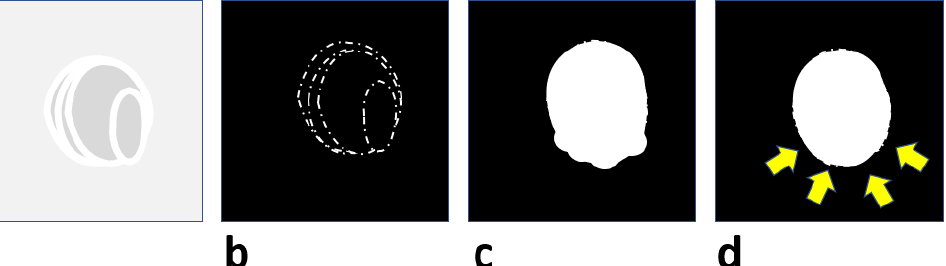
Figure 3. Schematic of the morphological construction of a bubble-type inclusion from the greyscale imagewhere, ( a ) represents the bubble-like inclusion, ( b ) the inclusion after the edges are detected, ( c ) inclusion further transformed into a solid particle and, ( d ) the cleaned and corrected inclusion morphology.